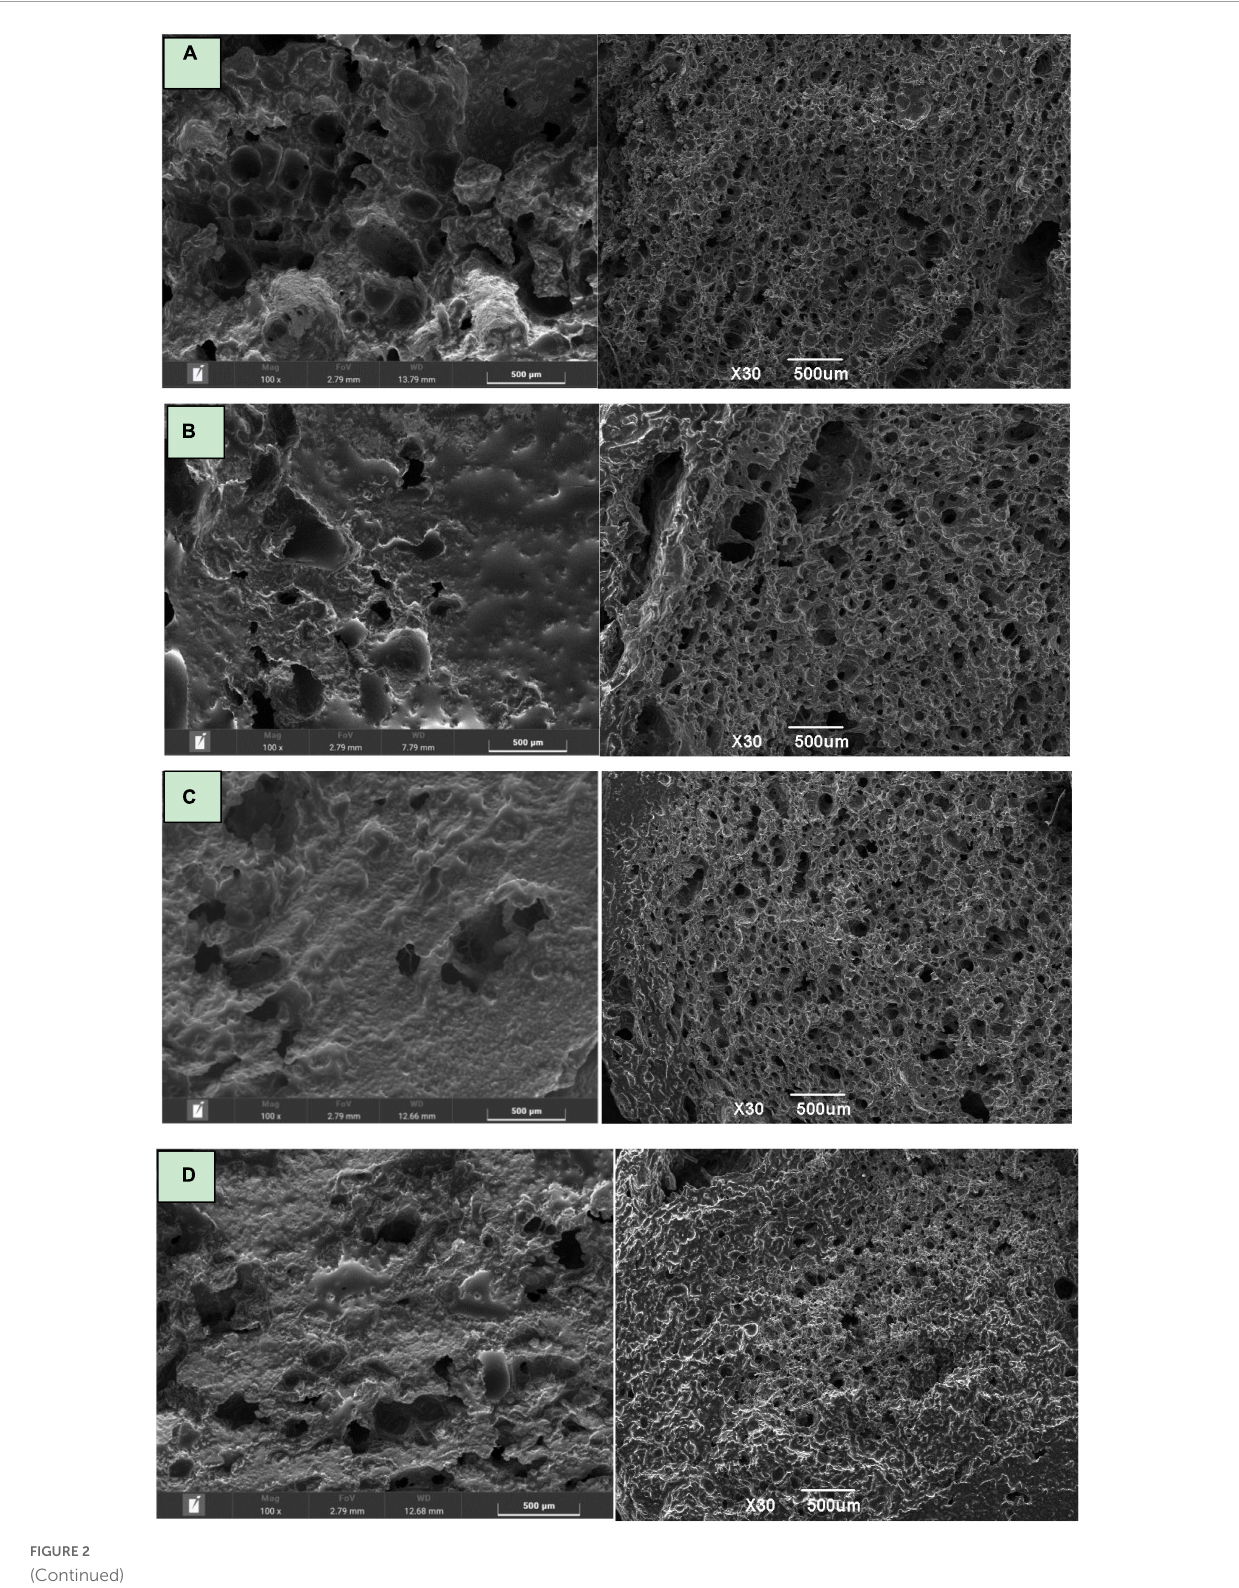
between control and different treatments. A decreasing trend of springiness was observed with increasing CH or CS levels. Low springiness reflects the tendency to crumble upon external forces